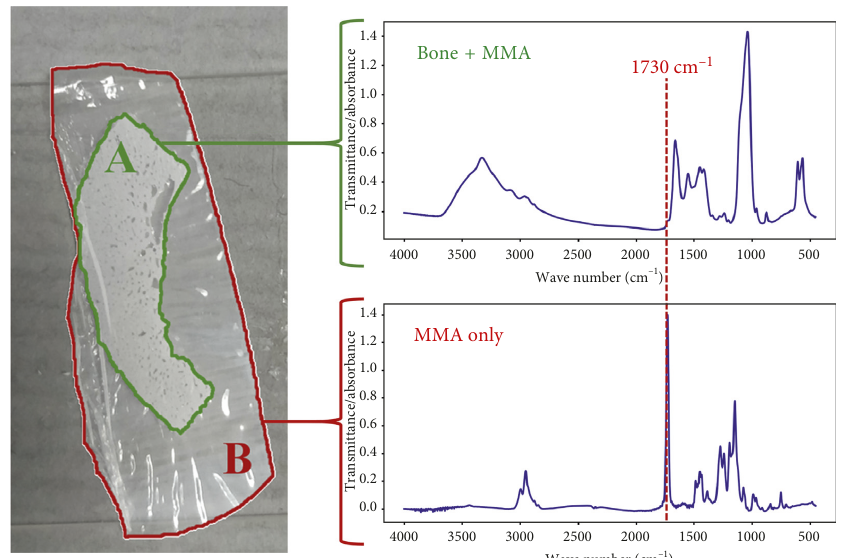
Figure 2: Typical sample of bone embedded in MMA (left) with its respective spectrum (top right) and the pure MMA spectrum (bottom right). A: cortical bone (human femur) embedded in MMA. B: methyl methacrylate (MMA). The MMA spectrum is taken outside the bone region of the sample.